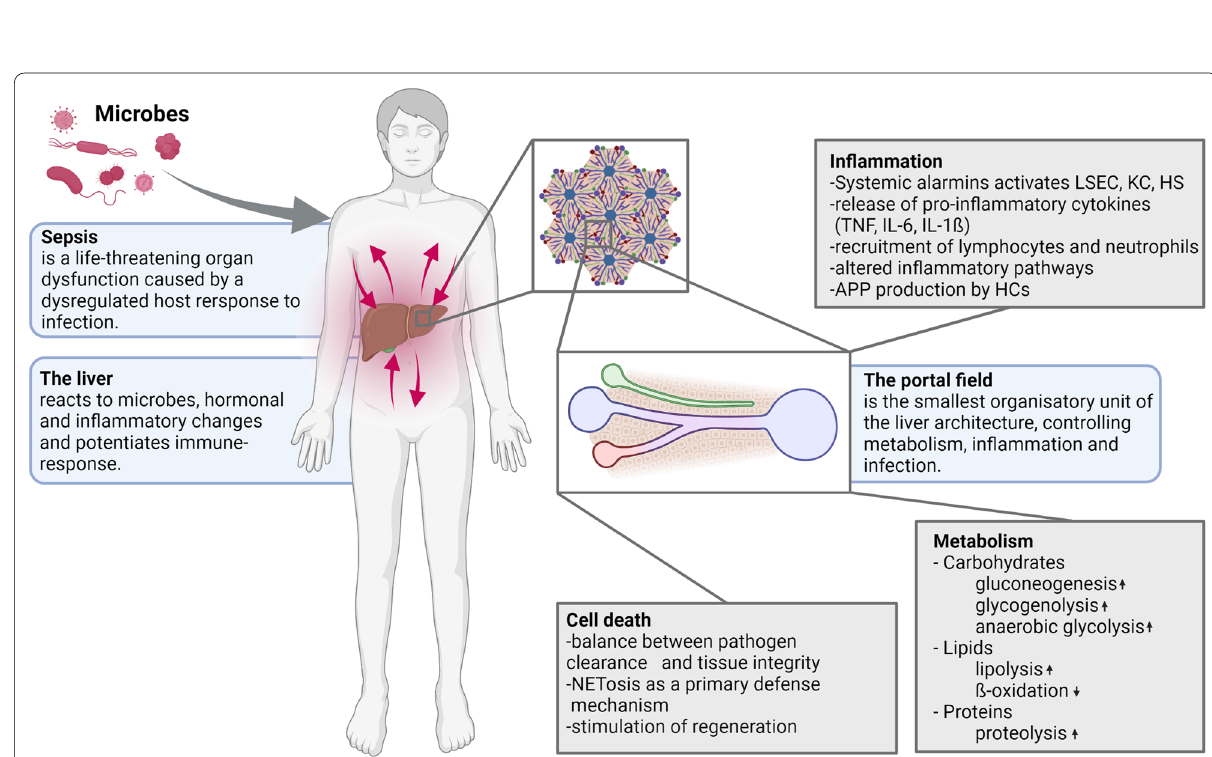
Fig. 1 The liver in sepsis. Key changes in the liver tissue during systemic infection that ultimately result in a dysbalanced host response and liver failure. (LSEC - Liver sinusoidal endothelial cell; KC - Kupffer cell; HS - Hepatic stellate